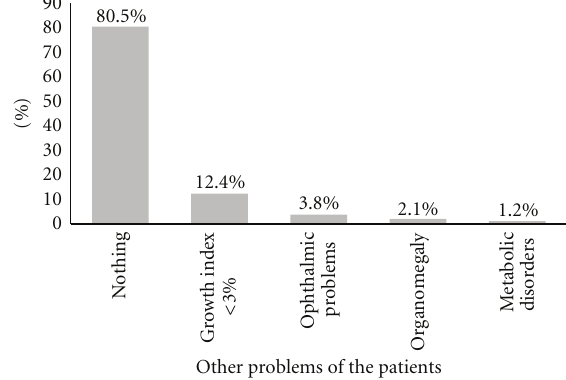
Figure 2: Percentage classification of di ff erent disorders in study groups.